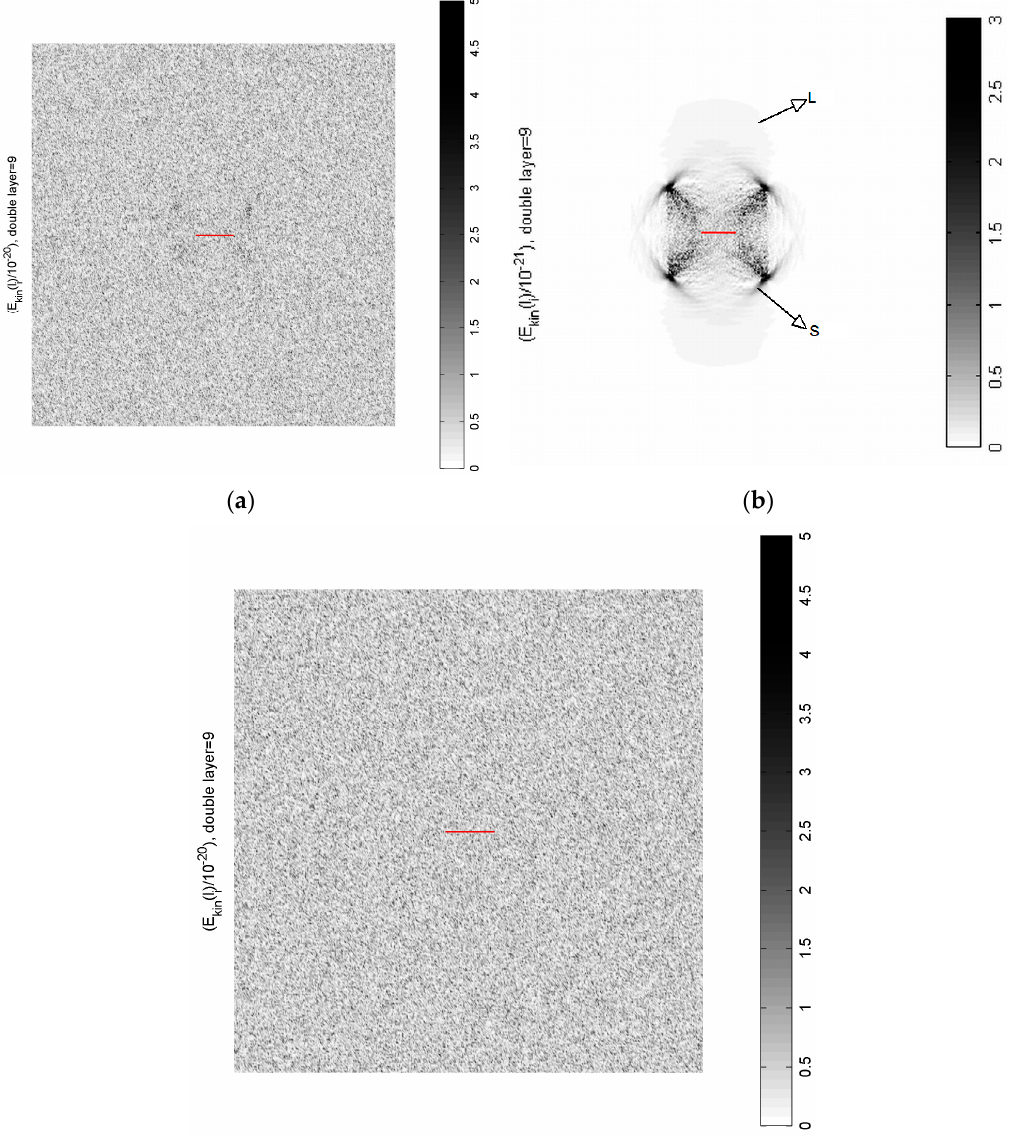
Figure 14. Map of the local kinetic energies E kin (li) of the individual atoms li in (110) double layer near B / 2: ( a ) temperature of ~300 K, α = 0.0, time step 7070; ( b ) temperature of ~0 K, α = 0.0, time step 8000; ( c ) temperature of ~300 K, time step 1000, free heating without any loading. The red line denotes the crack. The scale bar is on the right side: for ( a ) and ( c ) in units of (10 -20 J); for ( b ) in units of (10 -21 J).